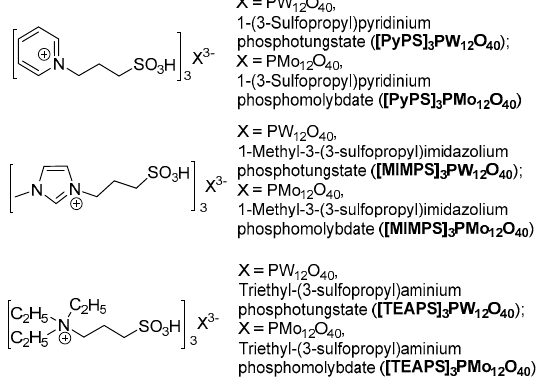
Figure 1. N -substituted imidazole, pyrdine and triethylamine based heteropolyanion-based ionic liquids (HPAILs).